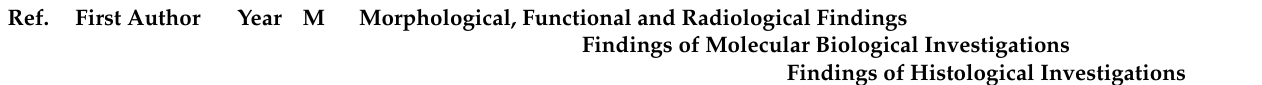
Table 1. Effects of the exposure of bone and cartilage tissue to extracorporeal shock waves (more details of the studies listed in this table are provided in Table